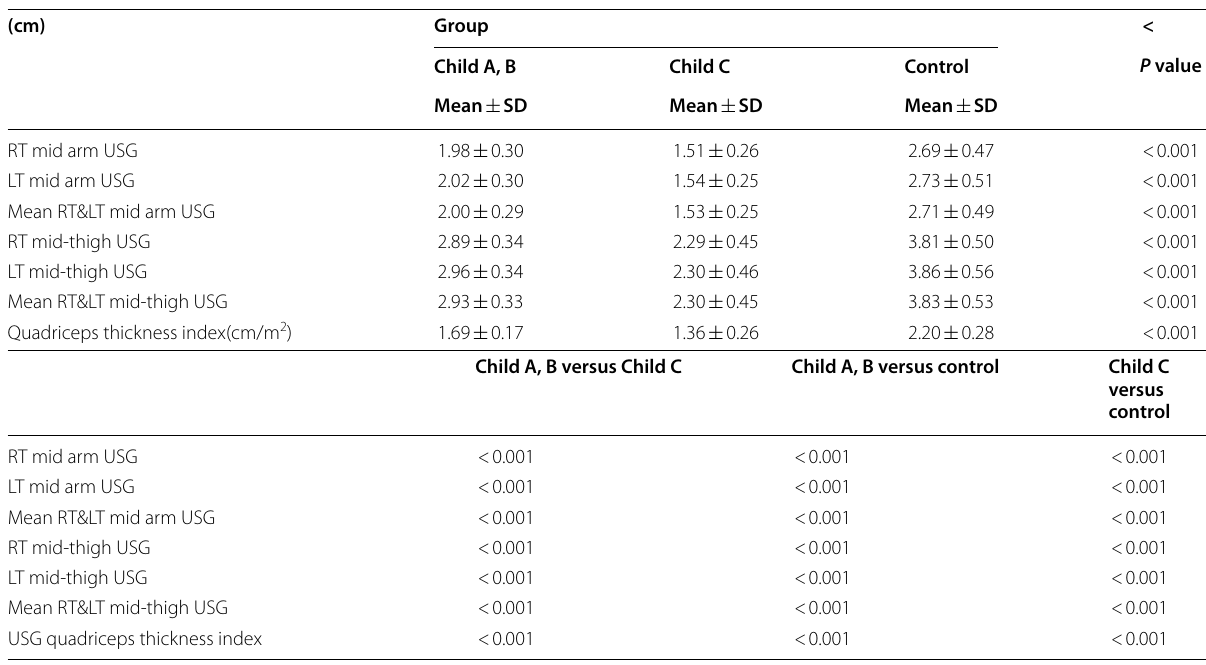
Table 6 Ultrasound mid upper arm, mid‑thigh muscle thickness and quadriceps muscle index